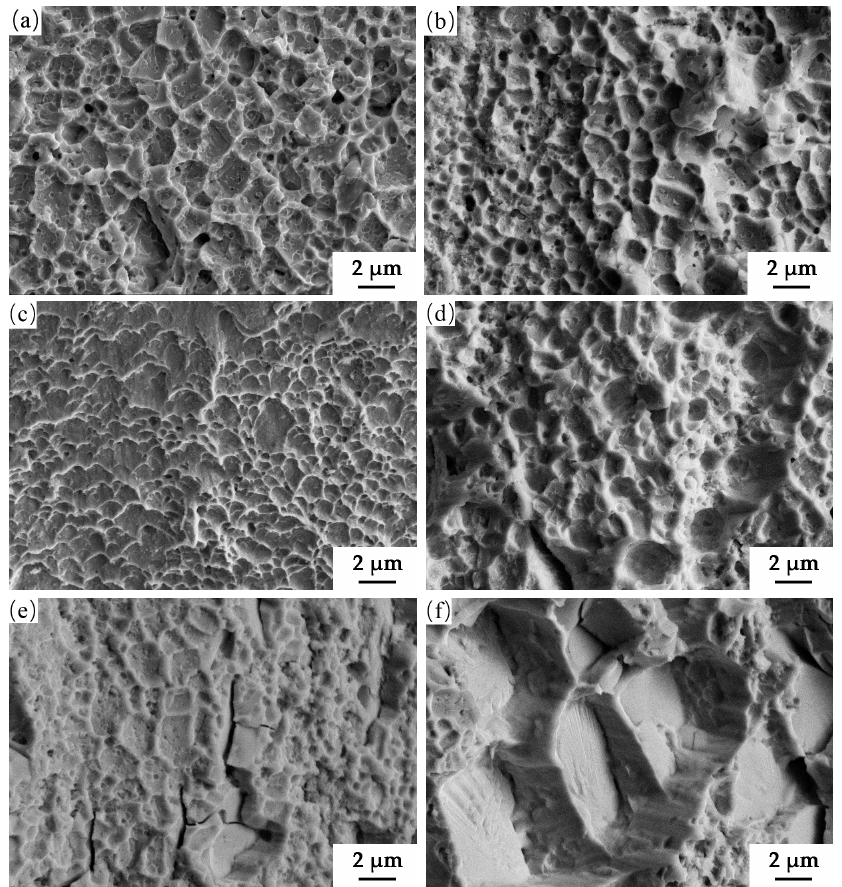
Figure 11. Fracture morphologies of the brazed joints of 12AgCuZnSn-2In-0.15Pr- x Ga filler metals